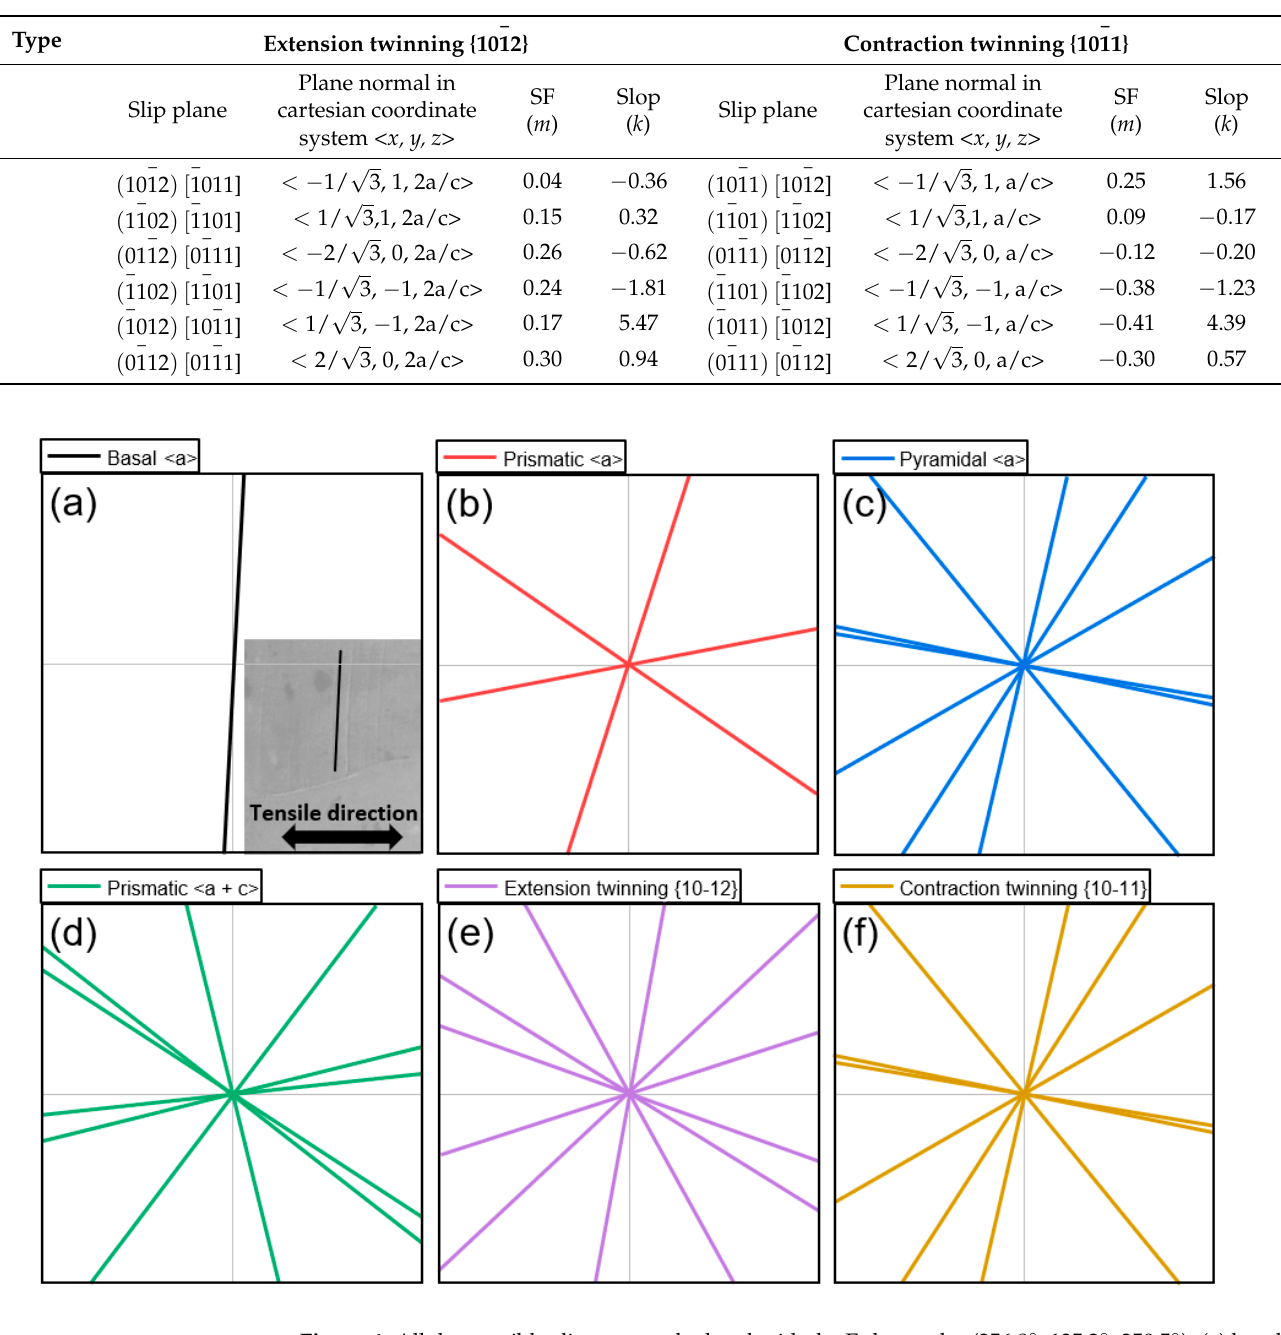
Figure 4. All the possible slip traces calculated with the Euler angles (356.8 ◦ , 135.2 ◦ , 250.5 ◦ ): ( a )